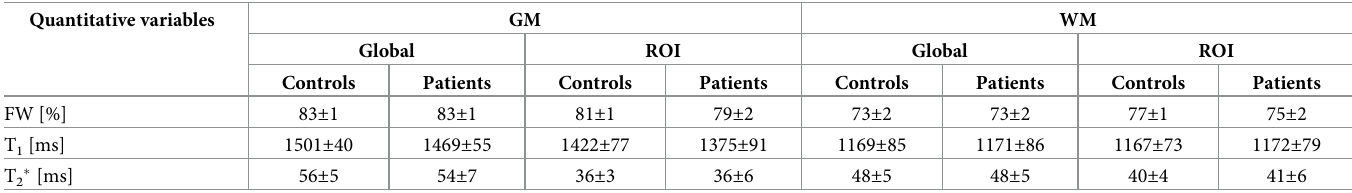
Following the removal of any small or irregular clusters, based on solidity, it can be seen that the biggest clusters are the two located in the vicinity of the expected location of the SN. This is visualised in Fig 6. Notice a very small number of remaining clusters and a significant difference in the volume between the first two clusters and the rest. The same situation was � , where the decreased value was distributed observed for each metric with the exception of T 2 across large regions within the whole brain and more clusters were detected globally. A Table 2. Mean values for water content and relaxation parameters for all GM/WM voxels and ROI. Quantitative